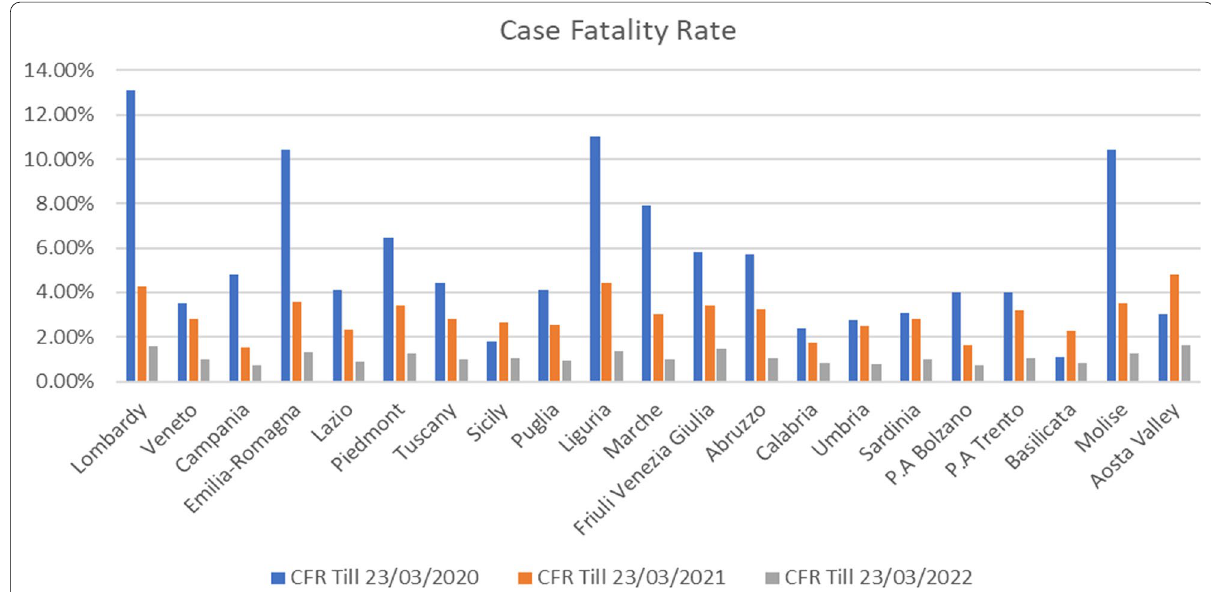
Fig. 4 Present scheme compares case fatality ratio (CFR) (percentage of deaths over positive cases was estimated) in three different years (2020, 2021 and 2022) for all regions. It is calculated by the number of deaths attributed to COVID-19 in each region which is divided by the total number of confirmed infected cases of COVID-19 in each region and then multiplied with